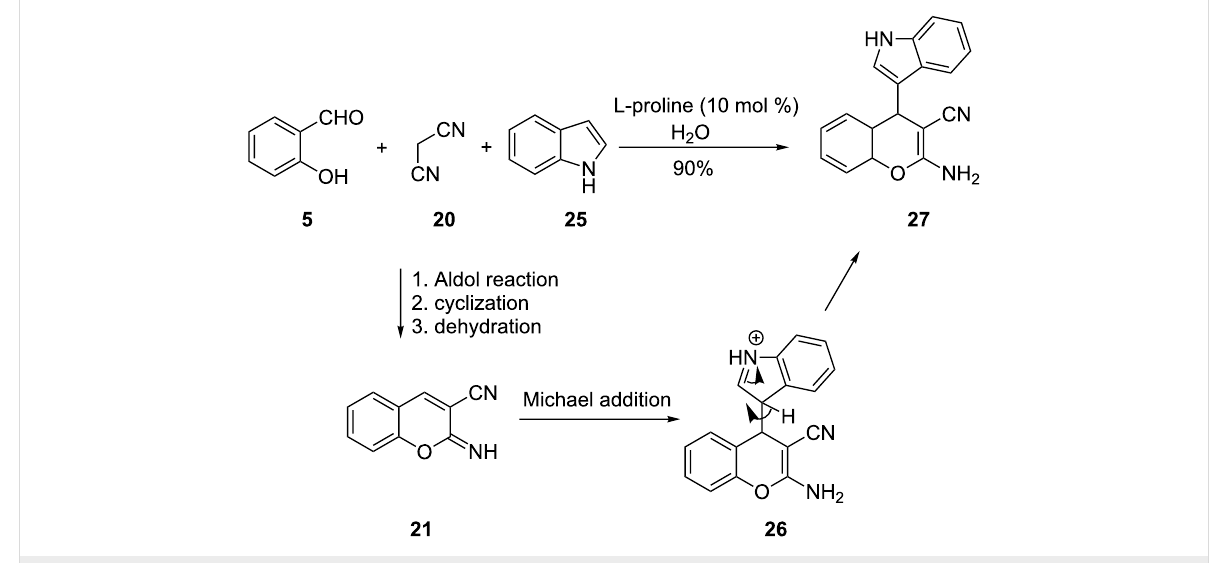
Scheme 10: Synthesis of 2-aminochromene 27 by Shanthi and co-workers.